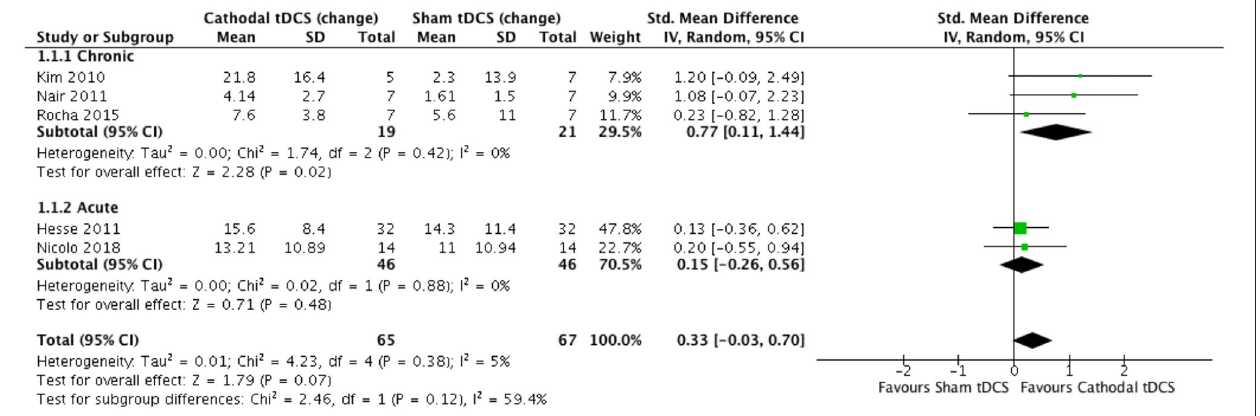
was evidence for low heterogeneity ( χ 2 = 0.02, p = 0.88; I 2 = 0%; τ 2 = 0.00) across